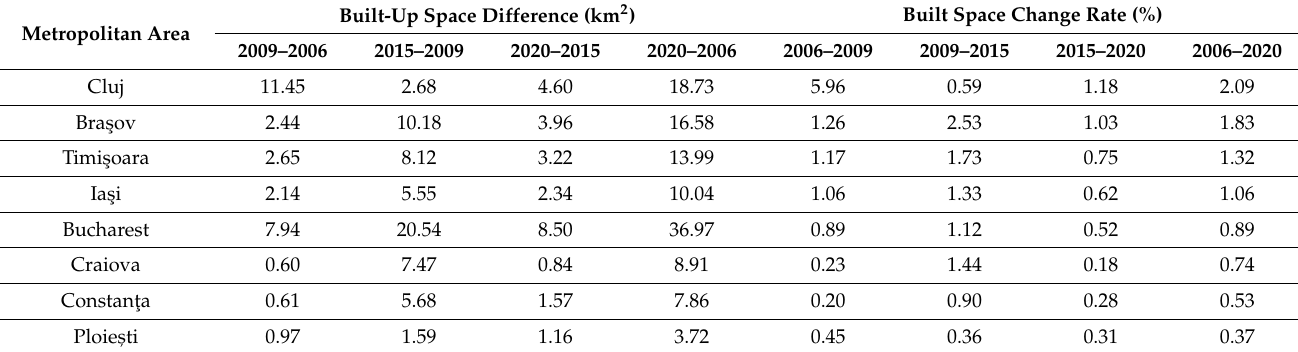
Table 7. The evolution of the built-up area in metropolitan areas.